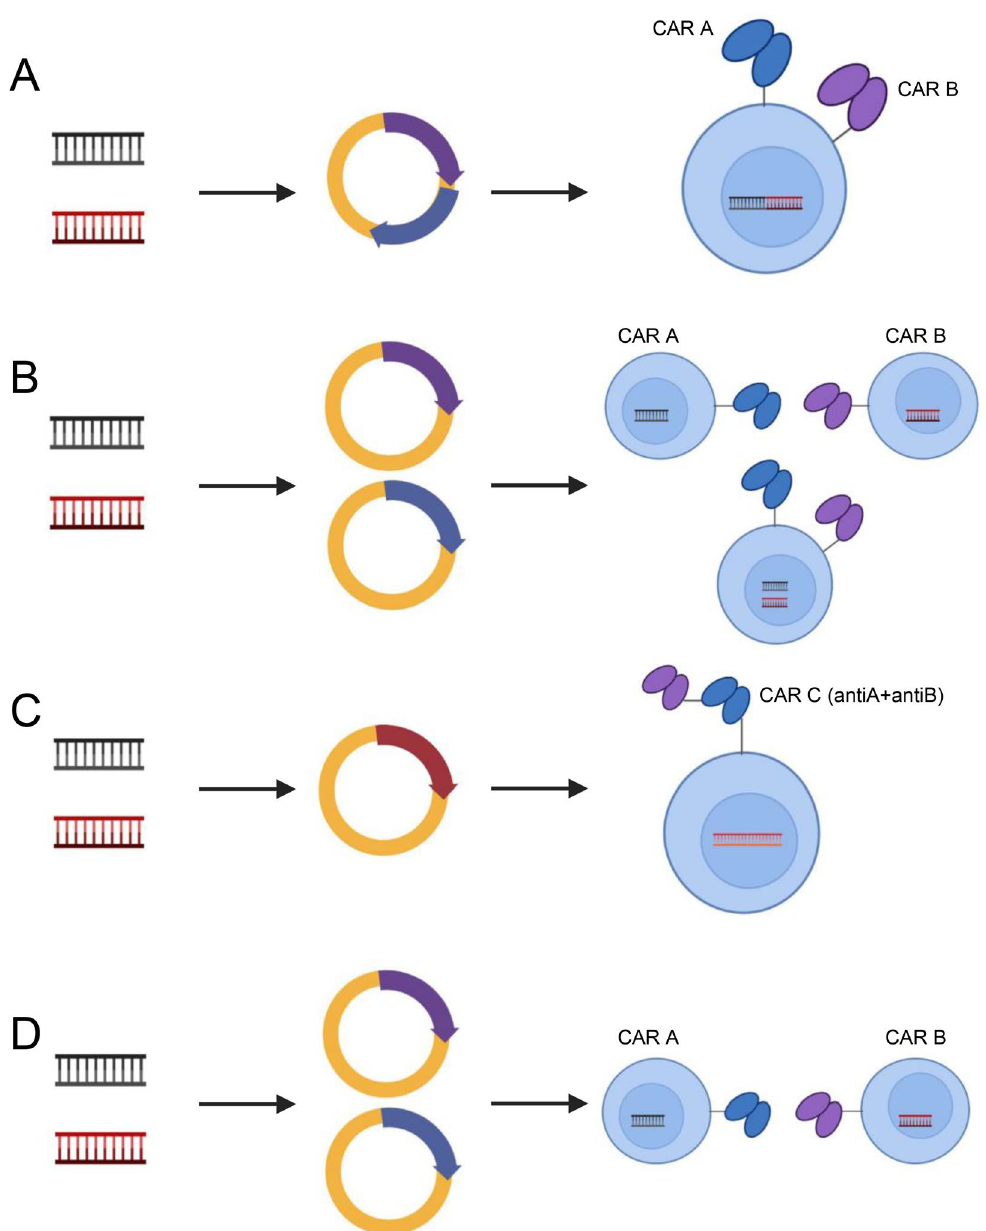
Figure 5. Dual-target CAR-T-cell therapy strategies. Dual-targeting CAR-T cells, including bicistronic transgenic ( A ), cotransduced ( B ), tandem single-chain antibodies ( C ) and coadministered or sequentially administered monospecific CAR T cells ( D ). Illustration was created with Biorender.com.